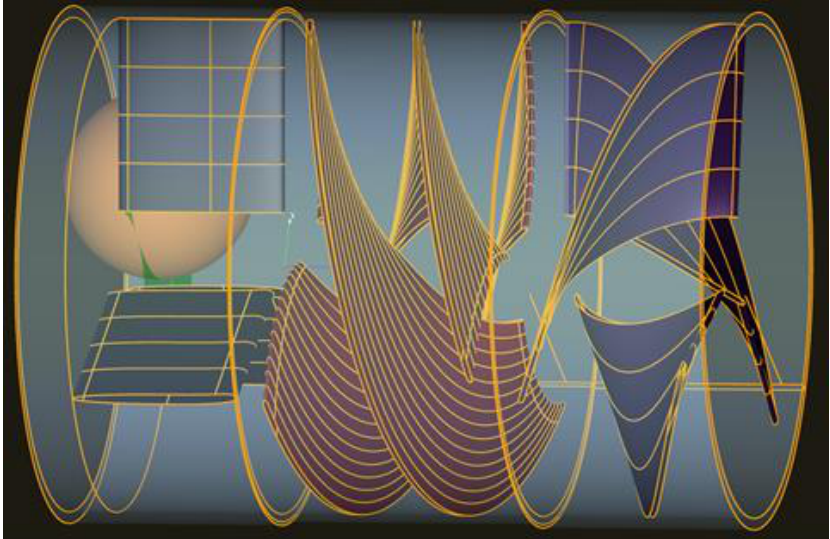
Figure 4. Resulting 3D geometries of the pump. From left to right: inducer (black), impeller (red), diffuser (purple).